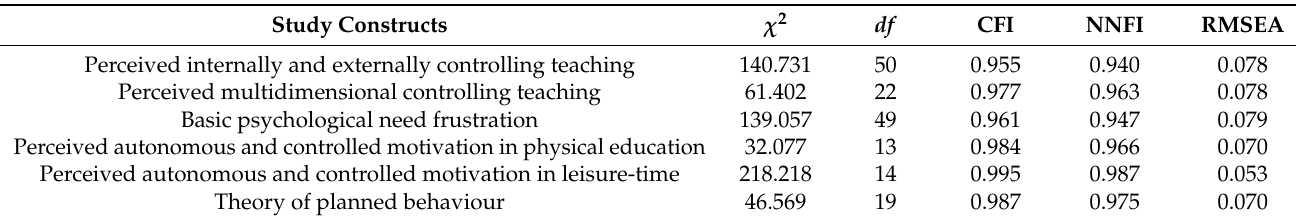
Table 2. Results of a confirmatory factor